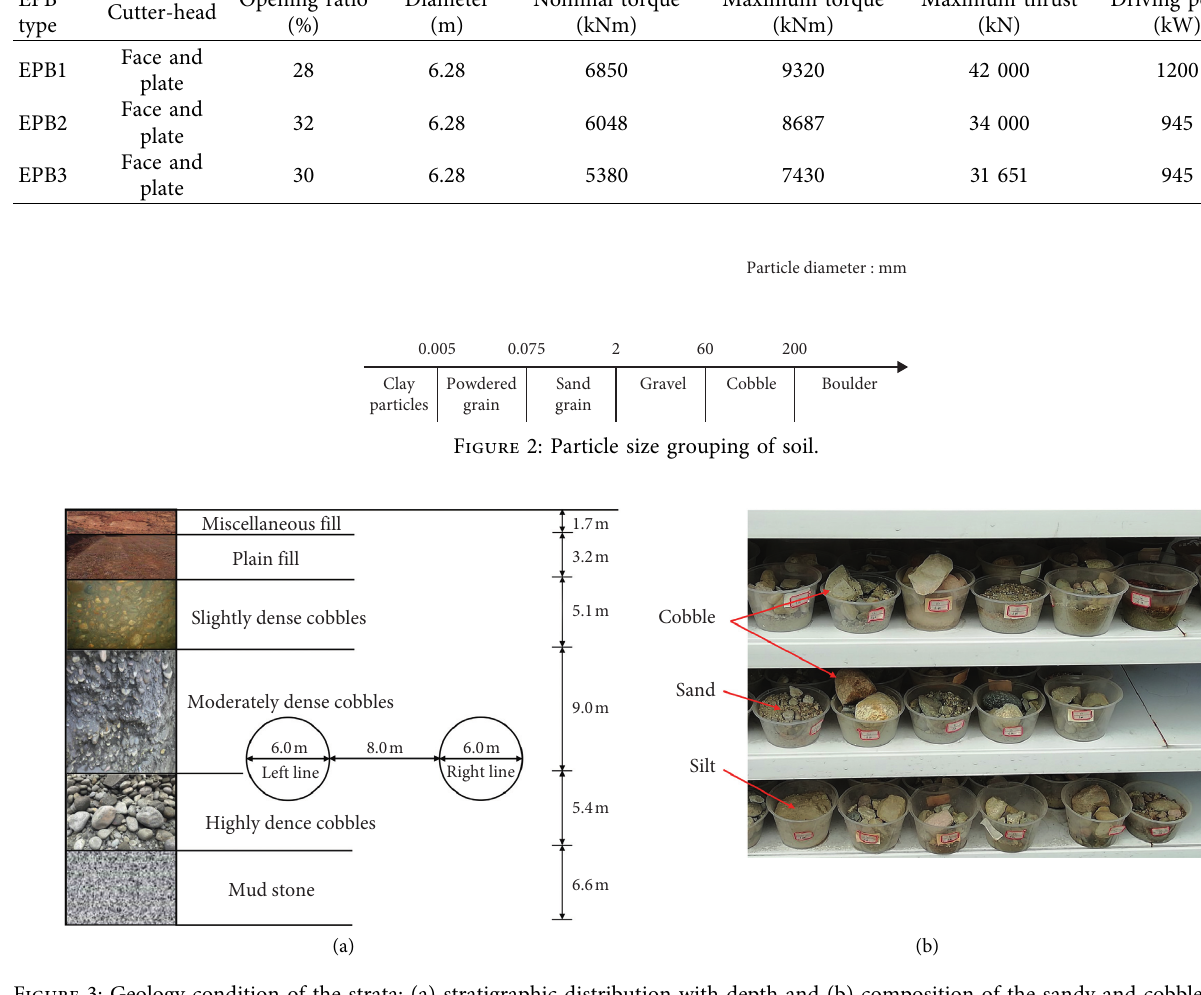
Figure 3: Geology condition of the strata: (a) stratigraphic distribution with depth and (b) composition of the sandy and cobble